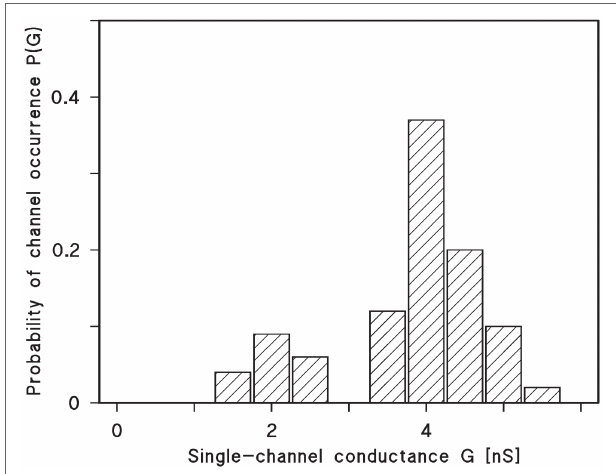
FIGURE 5 | Histogram of conductance fluctuations observed with membranes of diphytanoyl phosphatidylcholine/n-decane in the presence of Porin 31HL (Benz et al., 1992). P(G) is the probability for the occurrence of a conductance step with a certain single-channel conductance (given in nS). The aqueous phase contained 1 M KCl. The voltage applied was 10 mV. The mean value of all upward directed steps was 4.3 nS for the right-side maximum and 2.4 nS for the left-side maximum (in total 288 single events); T = 20 °